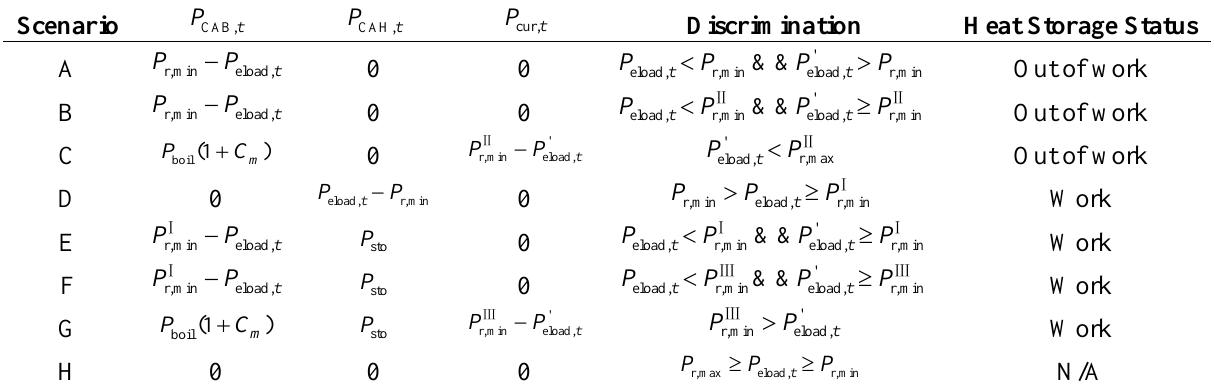
Table 2. The discriminants and parameters values for different